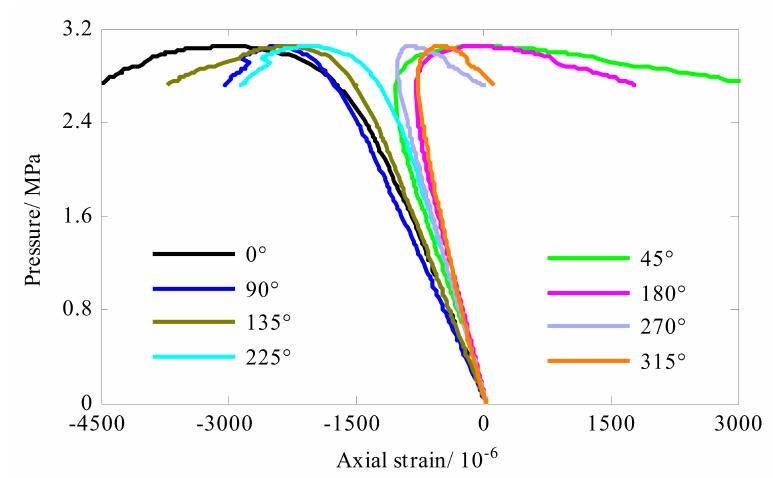
Figure 9. Strain response of the composite cylindrical shell A#.